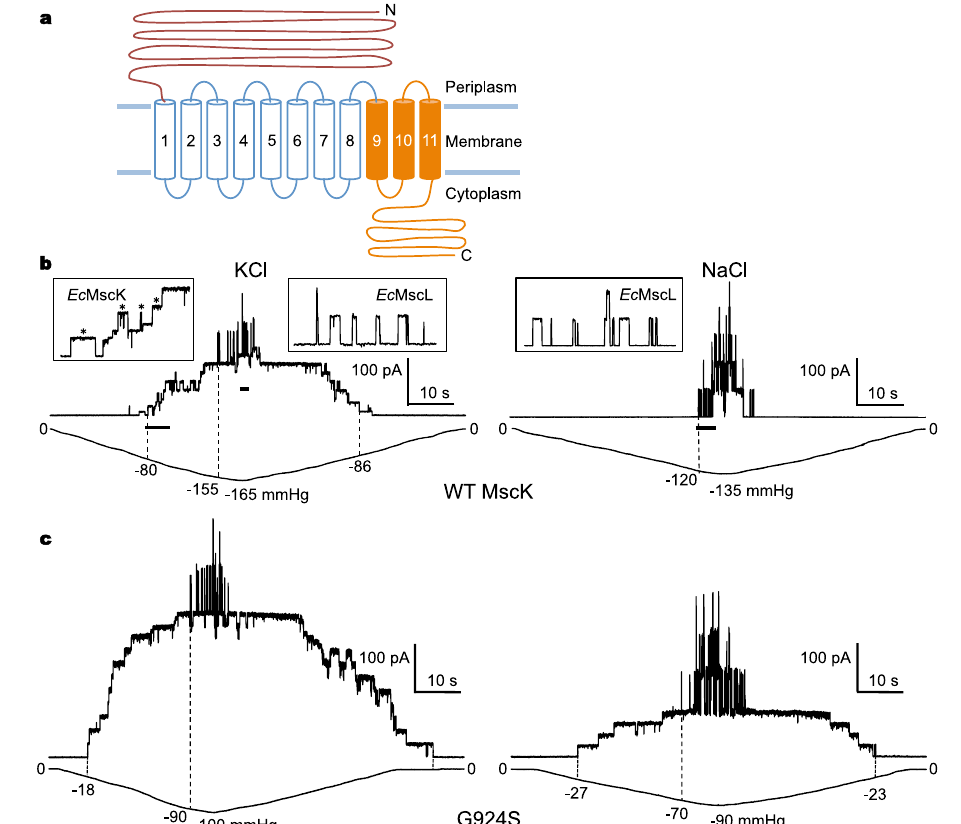
Fig.1|K + -dependentmechanosensitivechannelMscK.a Domaintopologyofthe MscK channel. The Ec MscS-like core, shared by all MscS homologs, is colored in orange.Incomparisonwith Ec MscSconsistingofthreeTMhelices,MscKhasalarge N-terminal periplasmic domain and eleven TM helices. b Current traces from membrane patches of giant spheroplasts from the E. coli strain pB113 expressing Ec MscK, in 200mM KCl (left) or 200mM NaCl (right). Membrane potential was − 30mV.Insets indicate the activityof Ec MscK(unitaryconductanceof895±25pS, 15independentpatches,dataweremean±SEM)or Ec MscL(unitaryconductanceof